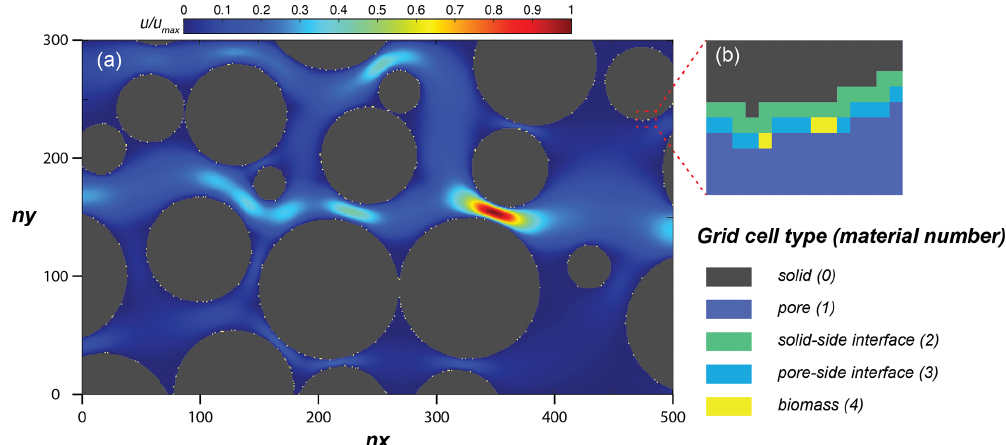
Figure 4. (a) Simulation domain of the model performance simulation, with the steady-state flow velocity distribution and (b) an enlarged subsection showing the distribution of material numbers around a solid. Table 1. Parameters used for all the model performance simulations. Symbol Description